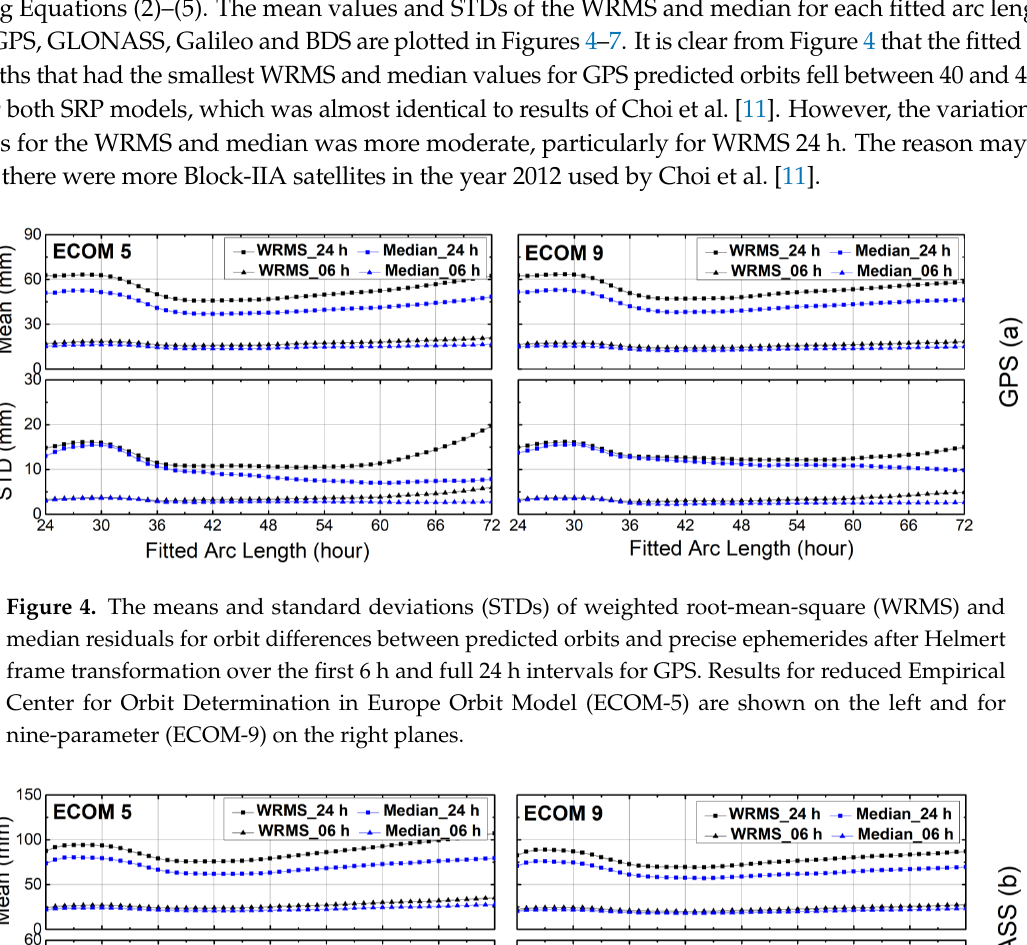
Figure 6. The means and standard deviations (STDs) of weighted root-mean-square (WRMS) and median residuals for orbit differences between predicted orbits and precise ephemerides after Helmert frame transformation over the first 6 h and full 24 h intervals for Galileo. Results for reduced Empirical Center for Orbit Determination in Europe Orbit Model (ECOM-5) are shown on the left and for nine-parameter (ECOM-9) on the right planes.